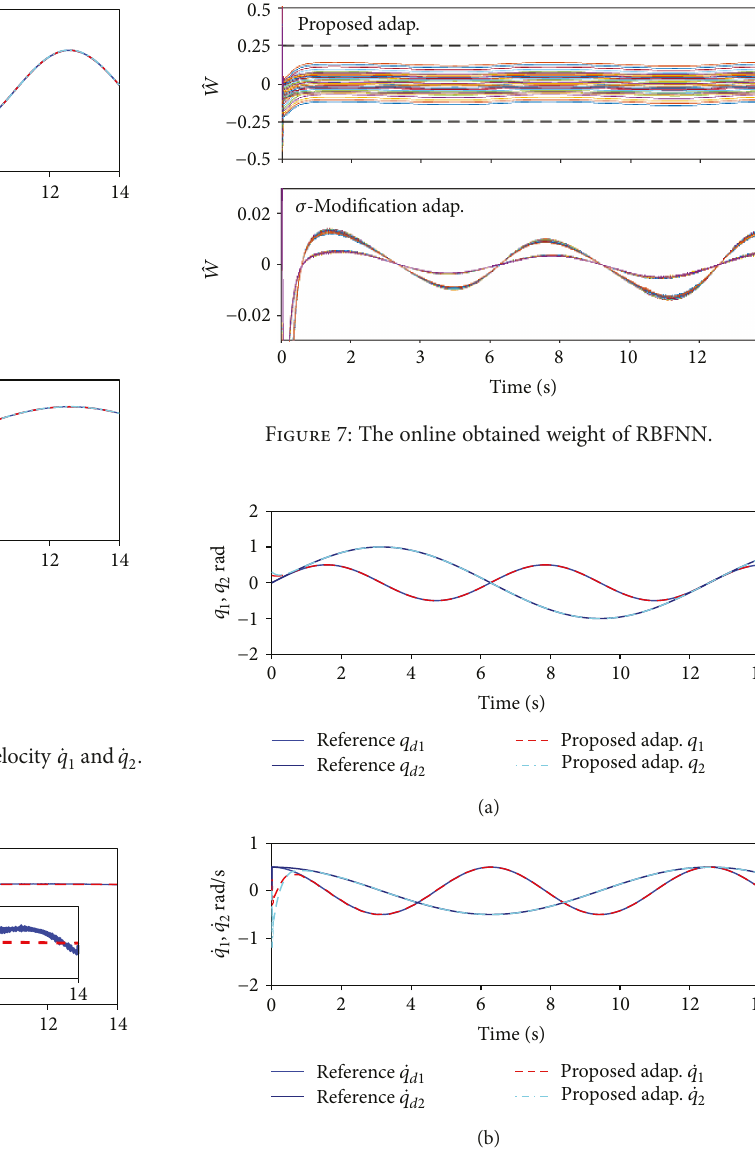
Figure 8: Tracking performance of the proposed adaptive law with bounded exogenous disturbances.